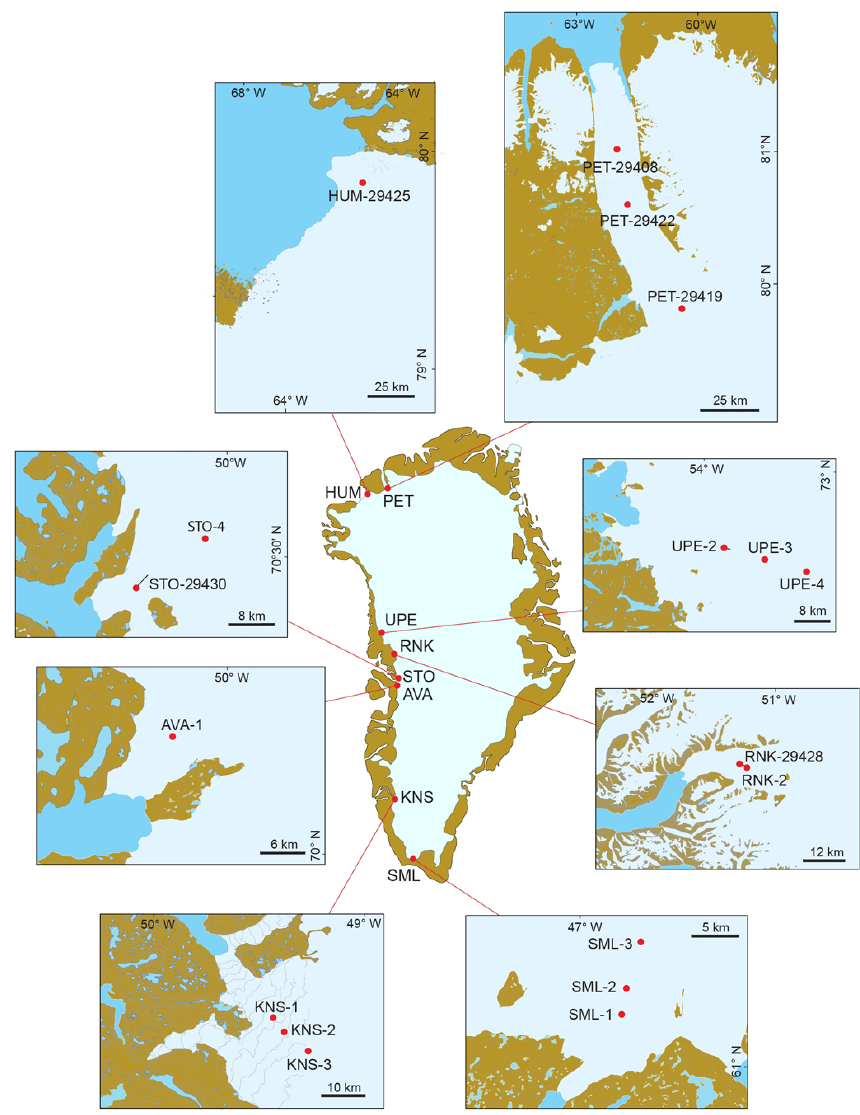
Figure 1. Map of locations, with inserts showing retrieval positions of GPS instruments on individual